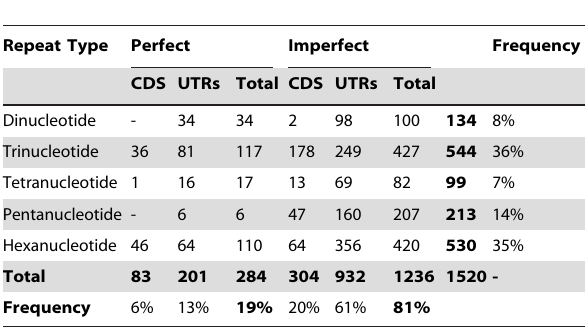
Table 2. SSR loci identified in Physalis peruviana leaf Expressed Sequence Tags